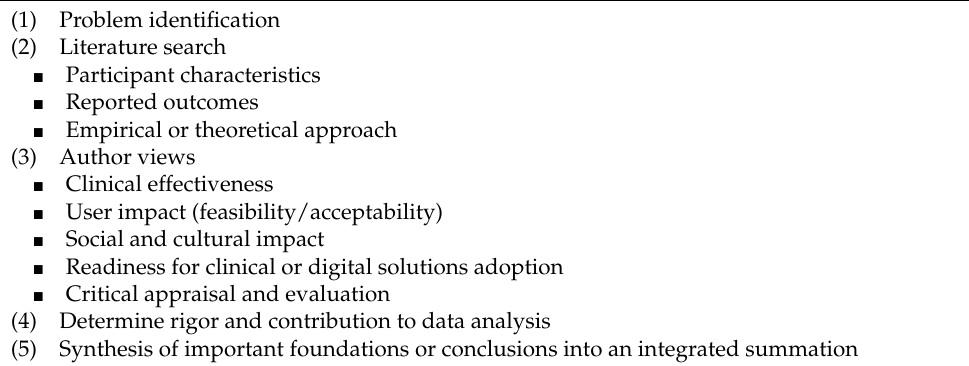
Table 1. Five step integrative review literature search